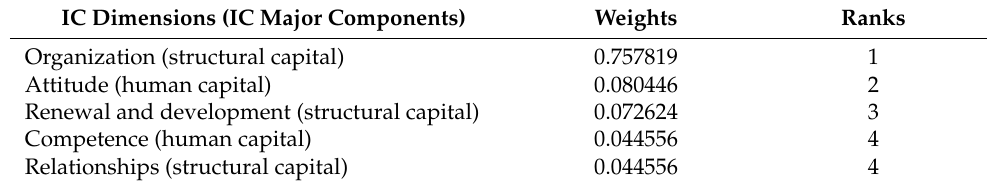
Table 4. Priorities and weights of IC